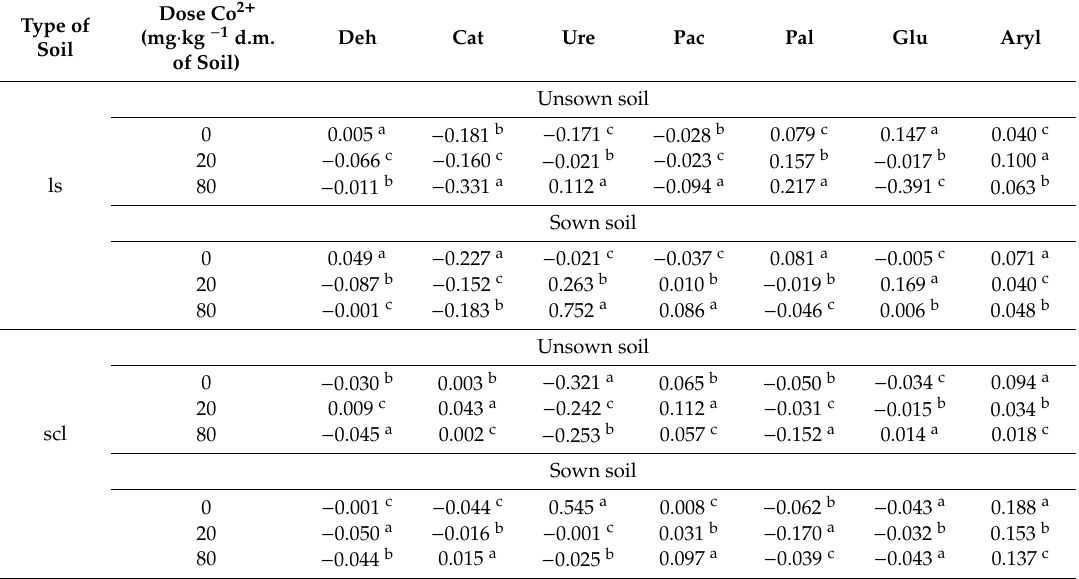
Table 11. Index of zeolite e ff ect ( IF z ) on the activity of enzymes in soil. Type of Soil